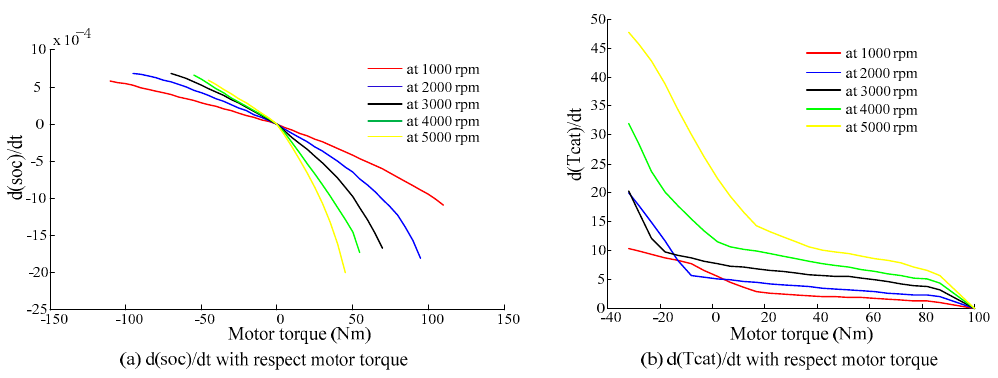
. . T cat ( u ) with respect to motor oc ( u ) and T u  with respect to motor torque. cat